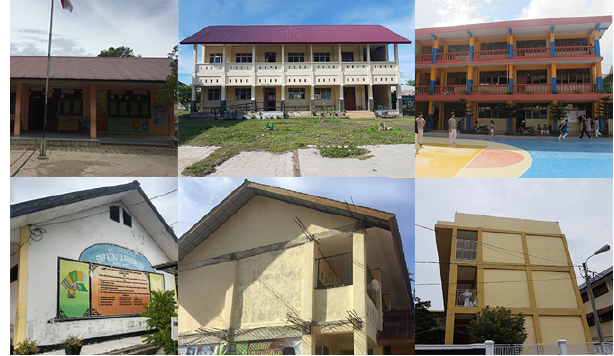
Figure 5. Sample photos of the building portfolio (taken on 16– 19 October